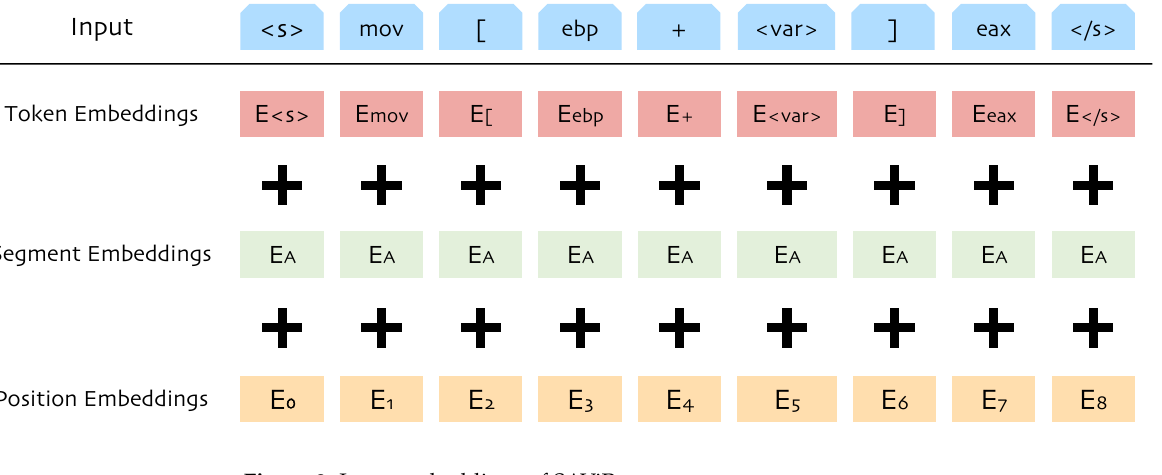
Figure 3. Input embeddings of